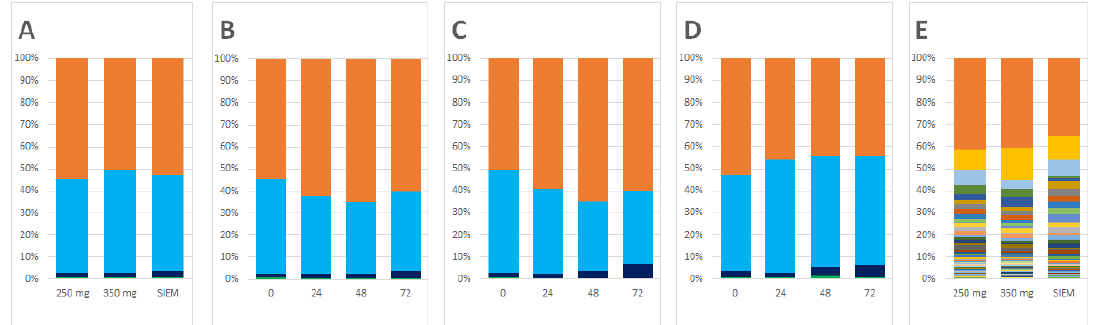
Figure 1. Composition in relative abundance of the samples from the in vitro model. ( A ) Composition at the start of the intervention at the phylum level (standard ileal efflux medium (SIEM)); ( B ) compositional changes over time for the 250 mg Citrus Fruit Extract (CFE) dose; ( C ) compositional changes over time for the 350 mg CFE dose; ( D ) compositional changes over time for the SIEM; ( E ) composition at the start of the intervention at the genus level. At the phylum level, the major phyla are shown: Bacteroidetes (orange); Firmicutes (light blue); Proteobacteria (dark blue). All other taxa were grouped under “Other” (green). For the genus level composition, the legend is provided in Table S1 for the top 25 genera, together with the quantitative data for all genera.